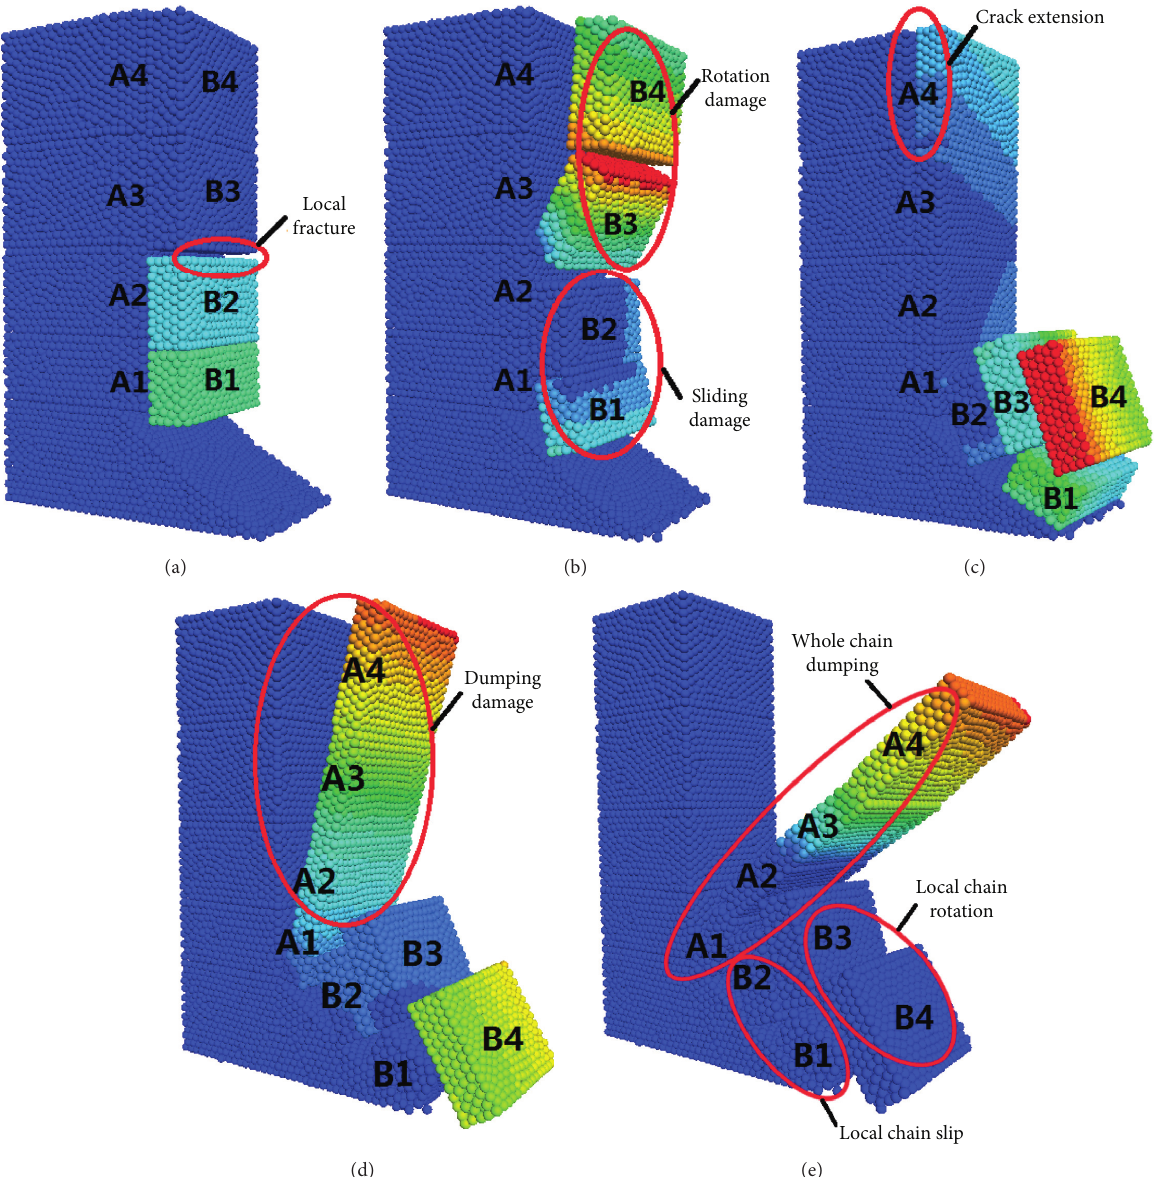
Figure 6: Failure modes at different times of Model 3. (a) t � 5s. (b) t � 10s. (c) t � 15s. (d) t � 20s. (e) t �